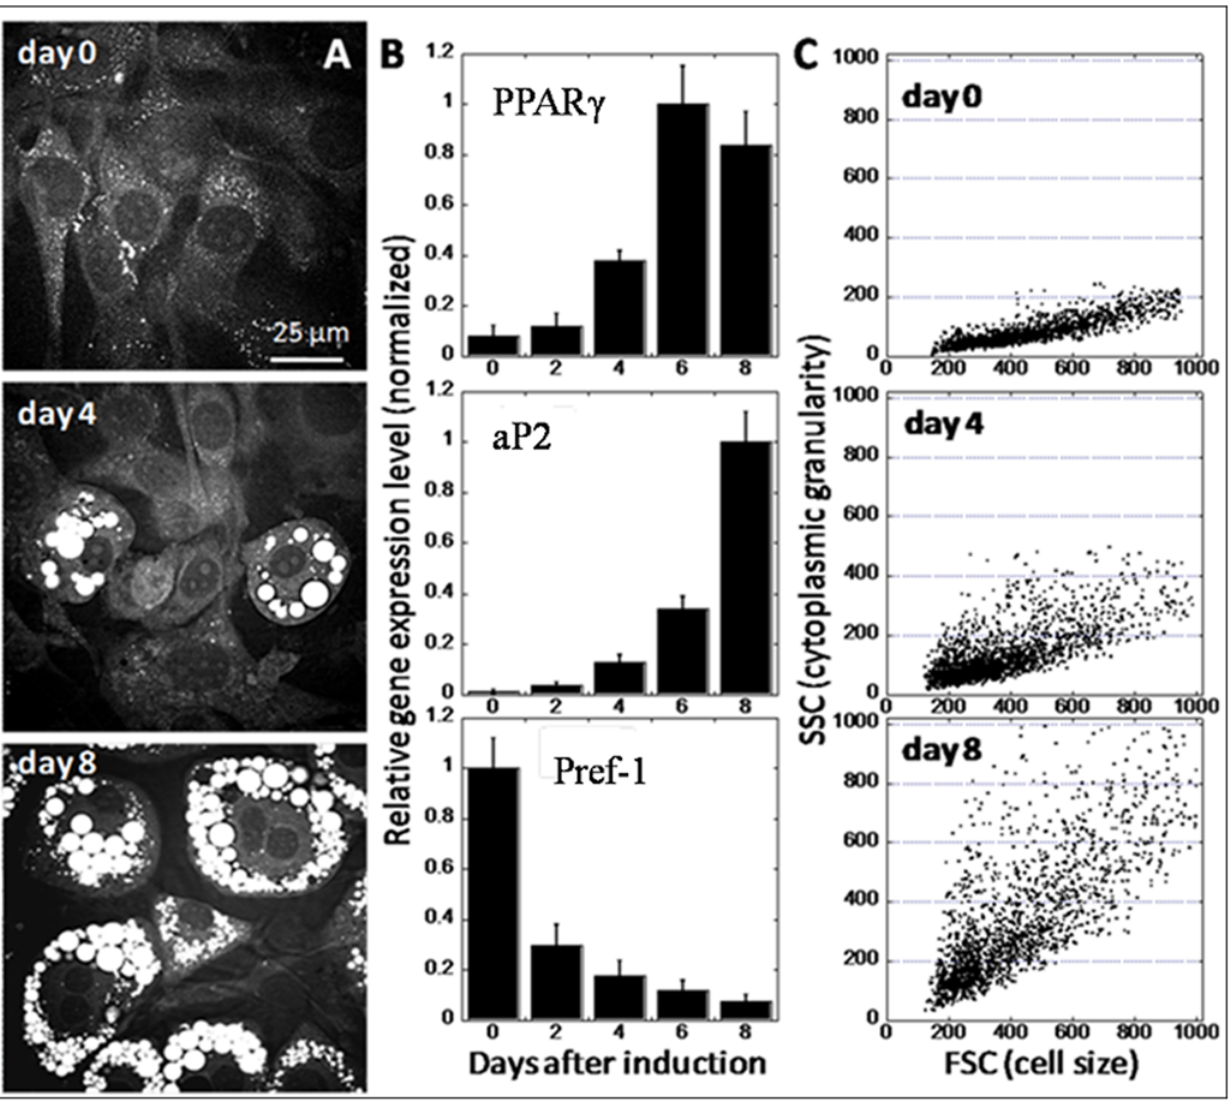
Figure 2. Monitoring adipogenesis with CARS microscopy, real-time PCR, and flow cytometry. ( A ) CARS visualization of intracellular lipid droplets accumulation as a function of time after adipogenesis induction. For CARS imaging, increased lipid droplet accumulation is due to increased of lipid amount in each cell. ( B ) Real-time PCR gene expression profiling of adipogenic gene markers as a function of time after adipogenesis induction. Adipogenic gene expression levels were corrected with expression level of a house-keeping gene acidic ribosomal phosphoprotein and normalized to 1 with the highest expression level. Error bars represent distribution across four repeated experiments. ( C ) Flow cytometry analysis of side scattering signal (SSC) which indicates cytoplasmic granularity caused by lipid droplets accumulation and forward scattering signal which indicates cell size.